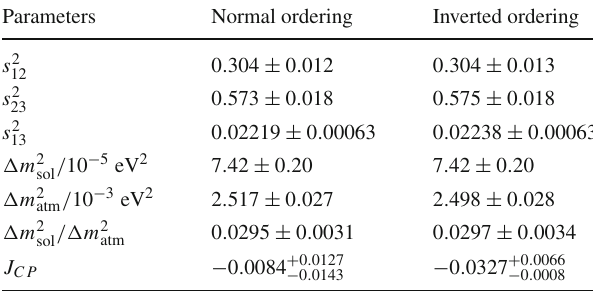
Table1 Centralvaluesandthe1 σ rangeforneutrinooscillationparam- eters obtained from Ref. [45] (see also [46]). In our analysis, we also consider the case of which θ 23 lies in the first octant